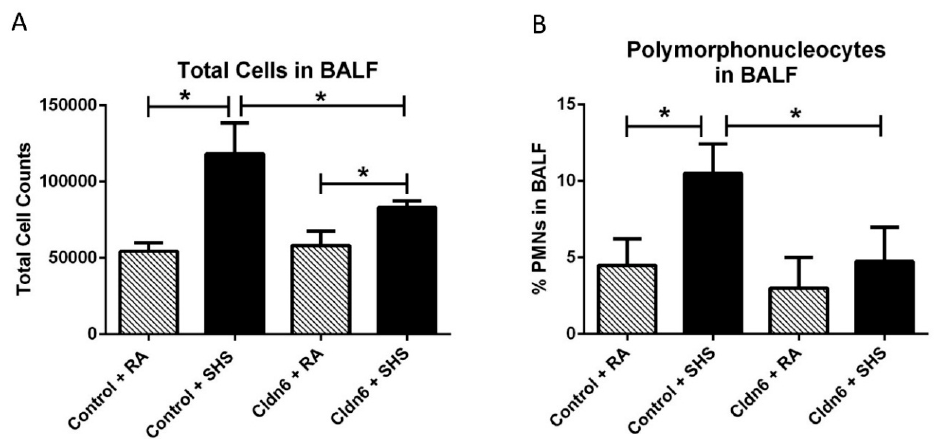
Figure 3. ( A ) Total bronchoalveolar lavage fluid (BALF) cells were significantly increased in control mice + SHS when room air (RA)-exposed controls. There was significantly less total cellularity in BALF from Cldn6 transgenic (TG) mice exposed to SHS when compared to SHS-exposed controls; ( B ) The percentage of polymophonuclear cells (PMNs) was significantly higher in control mice + SHS compared to control mice + RA and PMN quantity was unchanged in Cldn6 TG mice following SHS exposure. Data are representative of experiments involving six mouse lung samples per group and * p ≤ 0.05.